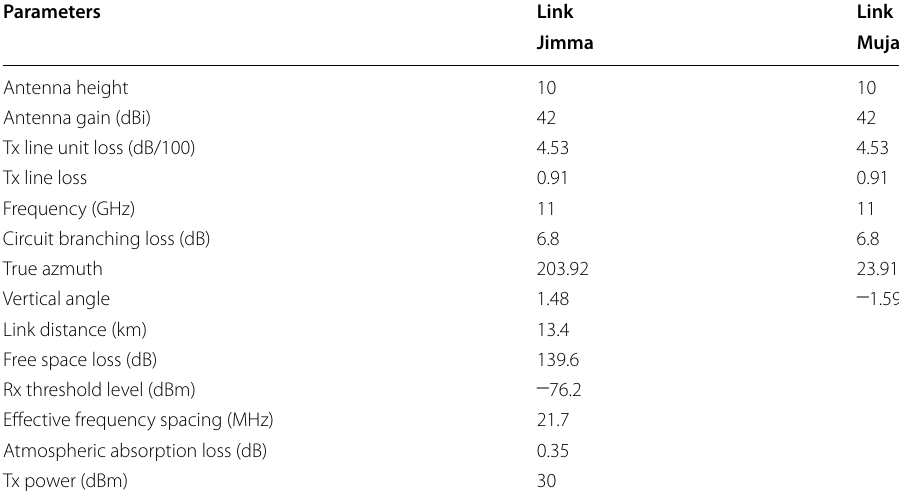
Table 2 Link parameters for terrestrial line of sight networks